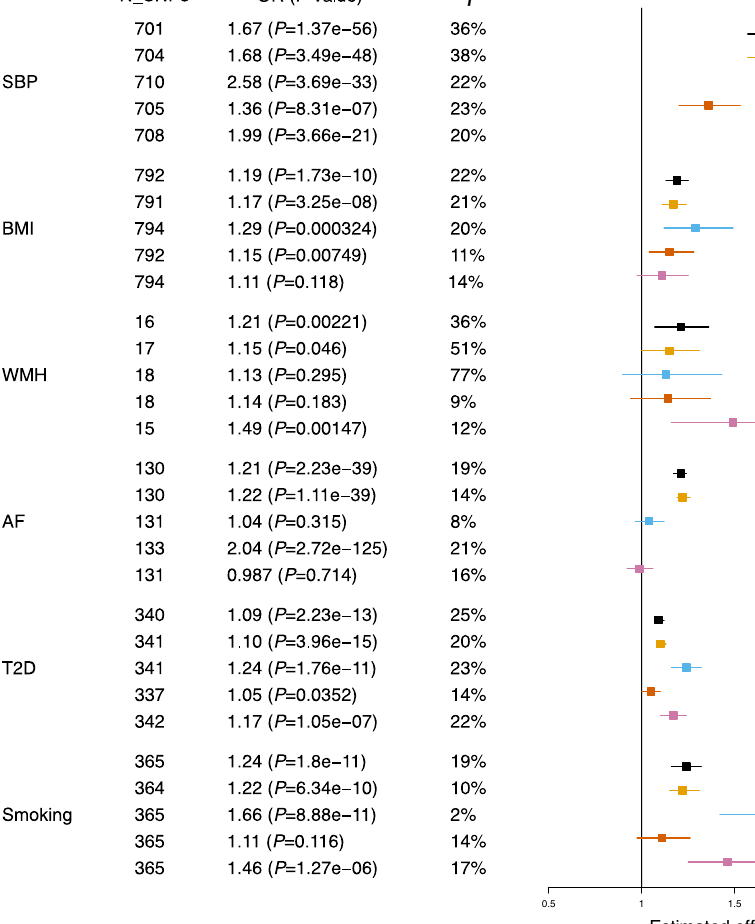
plot. P valuesweredeterminedfromtheinverse-variance-weightedtwo-sampleMR method. Statistical heterogeneity wasassessed using the I 2 statistic. ORodds ratio, SBPsystolicbloodpressure,AFatrial fi brillation,WMHwhitematterhyperintensity, T2D type 2 diabetes, BMI body mass index, Smoking smoking